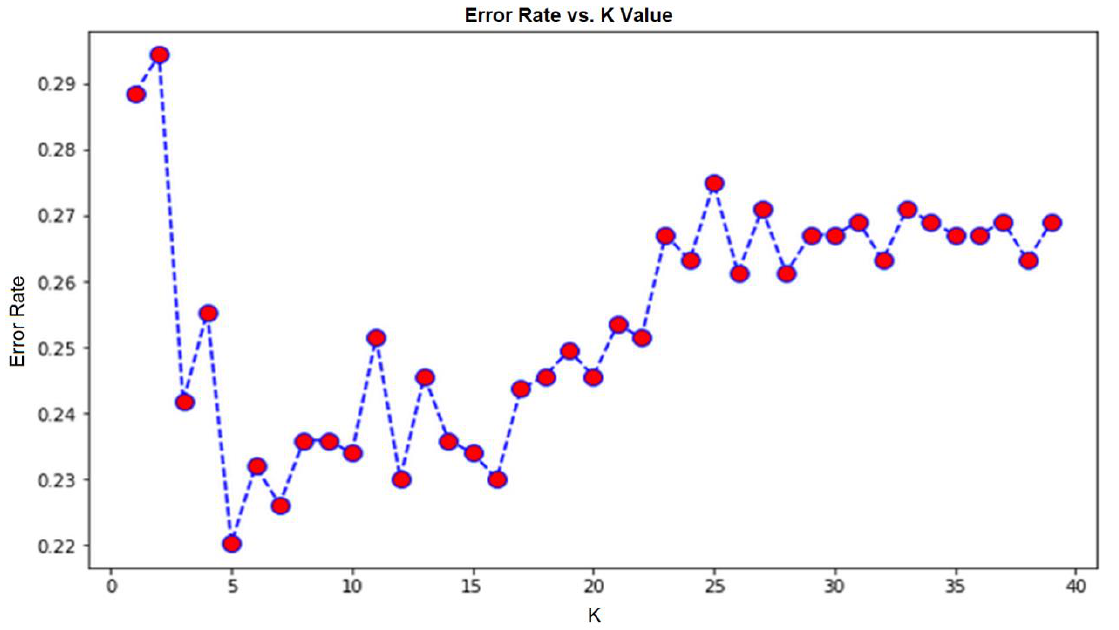
Figure 9. The error rate graph.